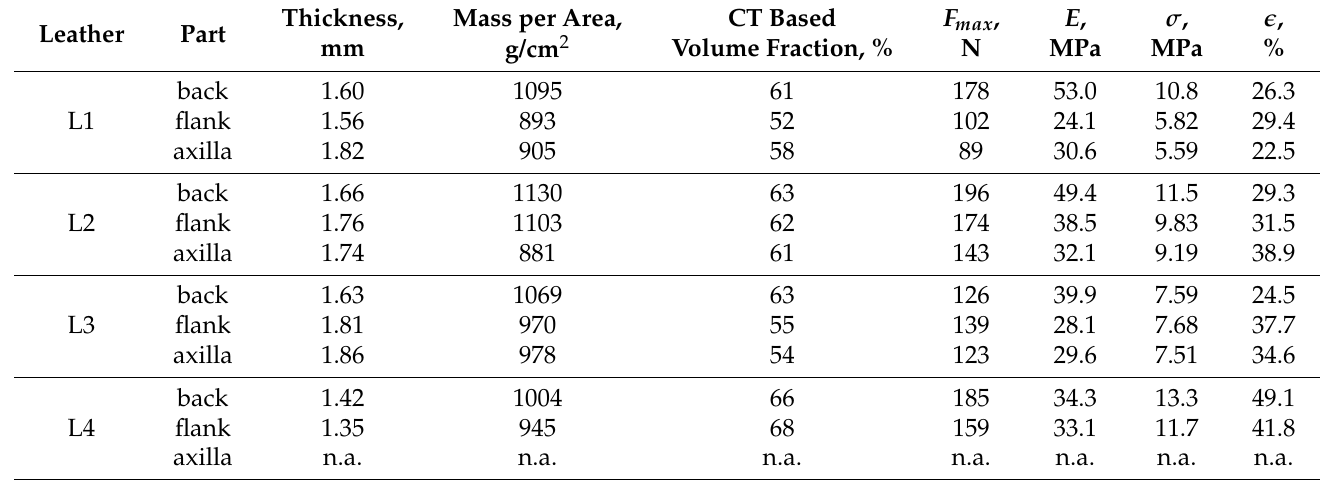
Table 1. Summary of physical and mechanical measurements for leathers